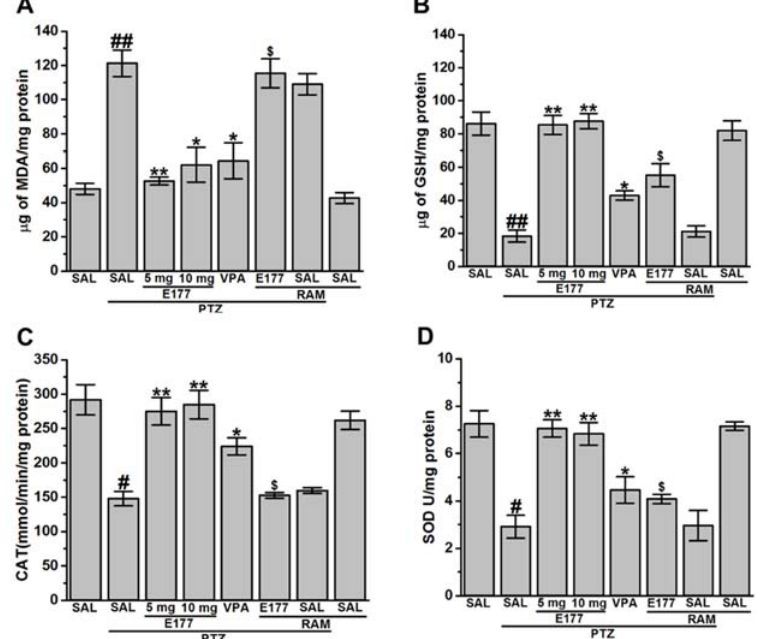
Figure 4. H3R antagonist E177 treatment mitigated altered oxidative stress levels associated with PTZ kindling model. Levels of glutathione (GSH), malondialdehyde (MDA), catalase (CAT), and superoxide dismutase (SOD) were assessed in rat hippocampus. PTZ-(40 mg / kg)-treated rats showed a significant decrease in GSH levels ( A ), CAT levels ( C ) and SOD levels ( D ) and a significant increase in MDA levels ( B ) when compared with saline-treated rats. E177 (5 and 10 mg / kg; i.p.) and VPA (300 mg / kg, i.p.) were administered 30–45 min prior each PTZ-injection. E ff ects of systemic co-injection with RAM (10 mg / kg, i.p.) on E177 (5 mg / kg)-provided modulation of oxidative stress levels were assessed. Data are expressed as the mean ± SEM ( n = 6). # P < 0.05 vs. saline-treated rats. ## P < 0.001 vs. saline-treated rats. * P < 0.05 vs. PTZ-kindled group. ** P < 0.001 vs. PTZ-kindled rats. $ P < 0.05 vs. E177(5 mg)-treated PTZ-kindled rats.